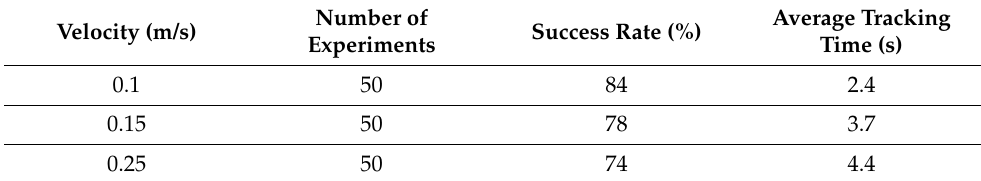
Table 4. Real environment tracking and grasping results.